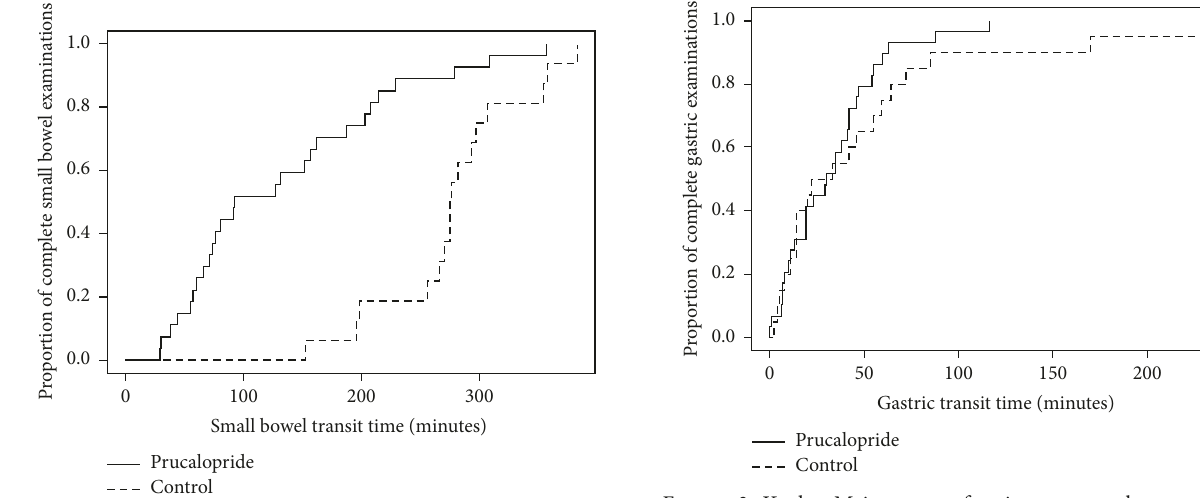
Figure 3: Kaplan-Meier curves for time to capsule passage into duodenum since the first gastric image for all VCE that reached duodenum.ThemedianGTTwasnotsignificantlydifferentbetween the prucalopride group (30, 95% CI: 19, 42) and the control group (27.5, 95% CI: 14, 72). VCE, video capsule endoscopy; GTT, gastric transit time; CI, confidence interval. Table 3: Summary of positive